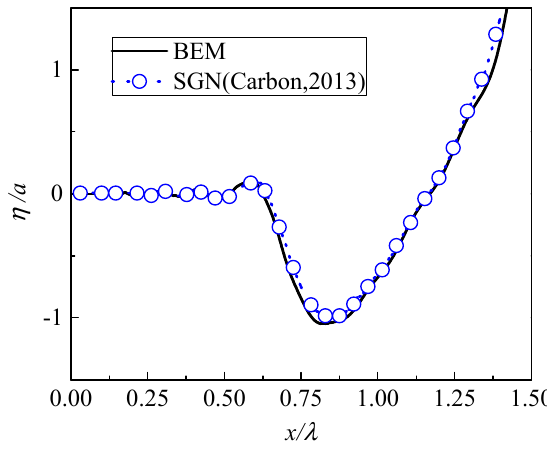
Figure 4. Free surface profile at t = 1.67 T for the single-crest wave train case.